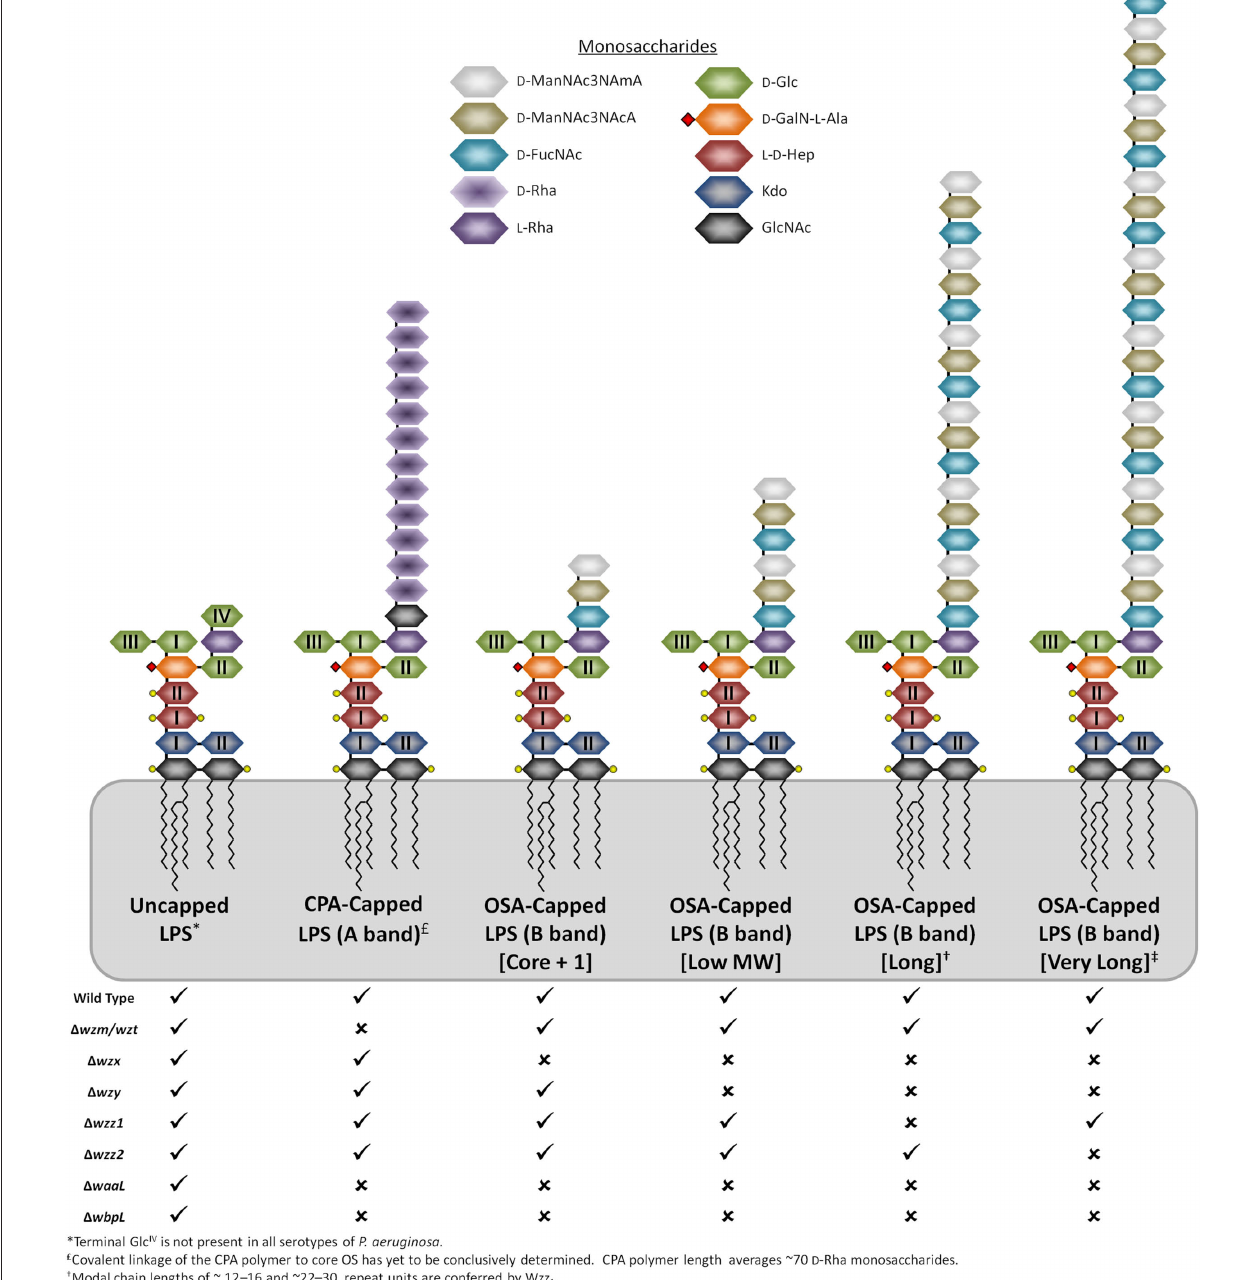
or “  ” representing their presence or absence, respectively. Substitutions of various lipid A and core OS sugars with phosphate groups and l -Ala have been indicated with yellow circles and red diamonds, respectively. The OSA polymer from serotype O5 has been displayed as a representative